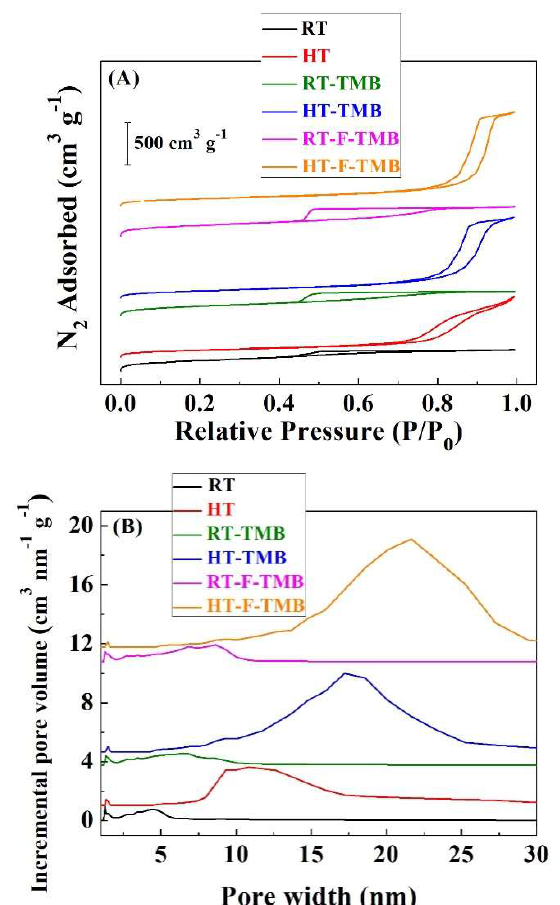
Figure 3. N 2 adsorption-desorption isotherms ( A ) and pore size distribution ( B ) of the Zr-doped porous silicas.